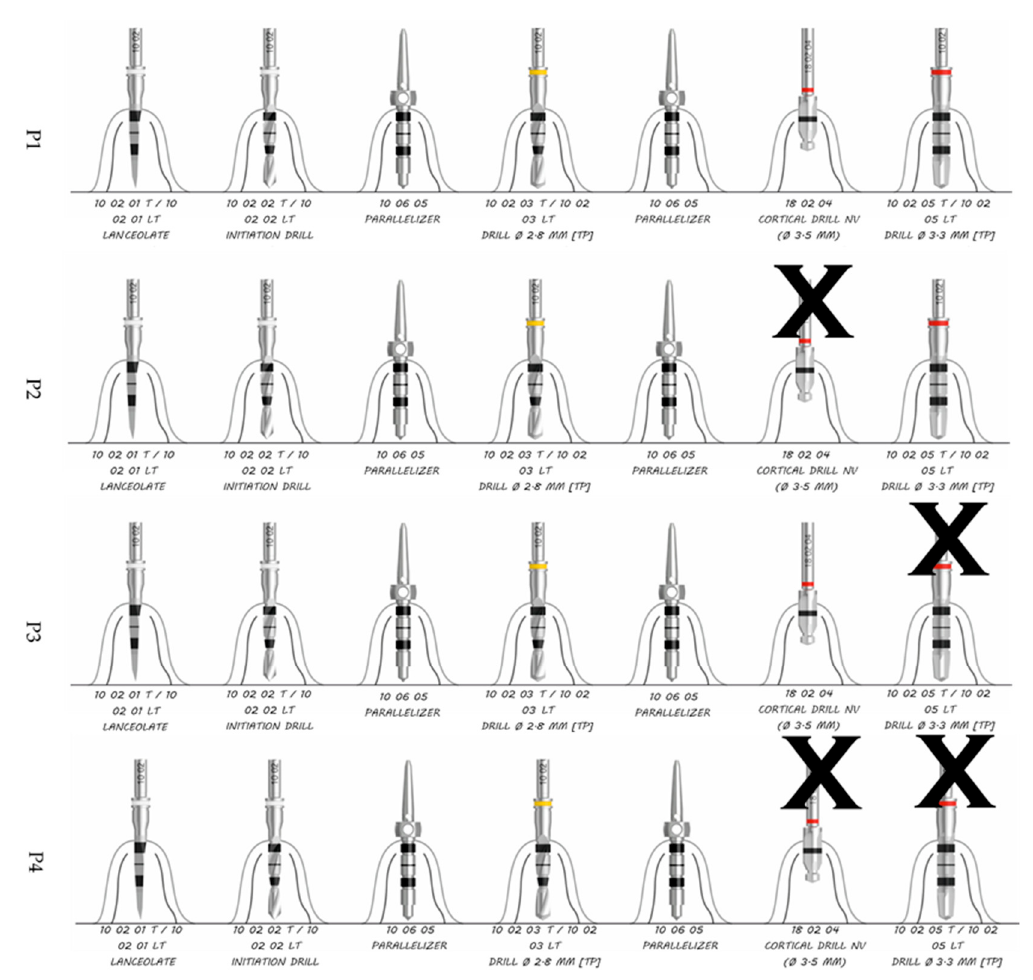
Figure 1. P1, P2, P3 and P4 site preparation sequence for 3.5 mm diameter.